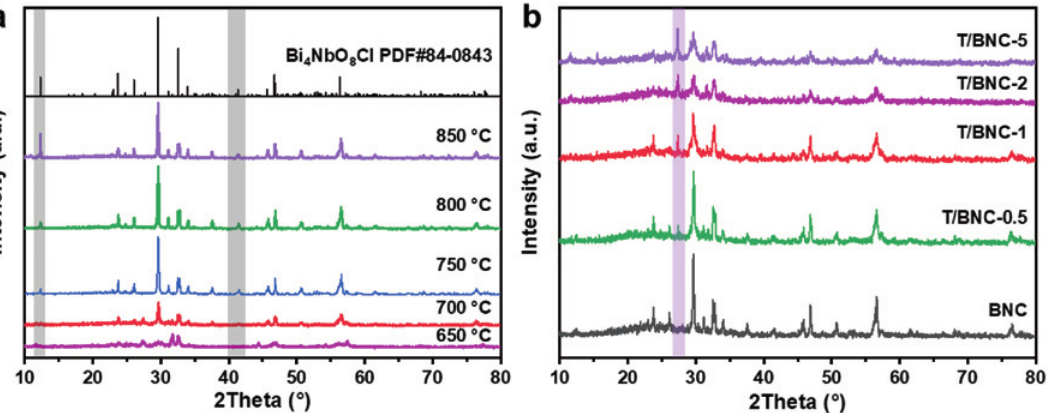
Figure 1: X-ray diffraction patterns of (a) pristine Bi 4 NbO 8 Cl synthesized by different temperatures, (b) T/BNC-x synthesized at 750 ° C in the fl